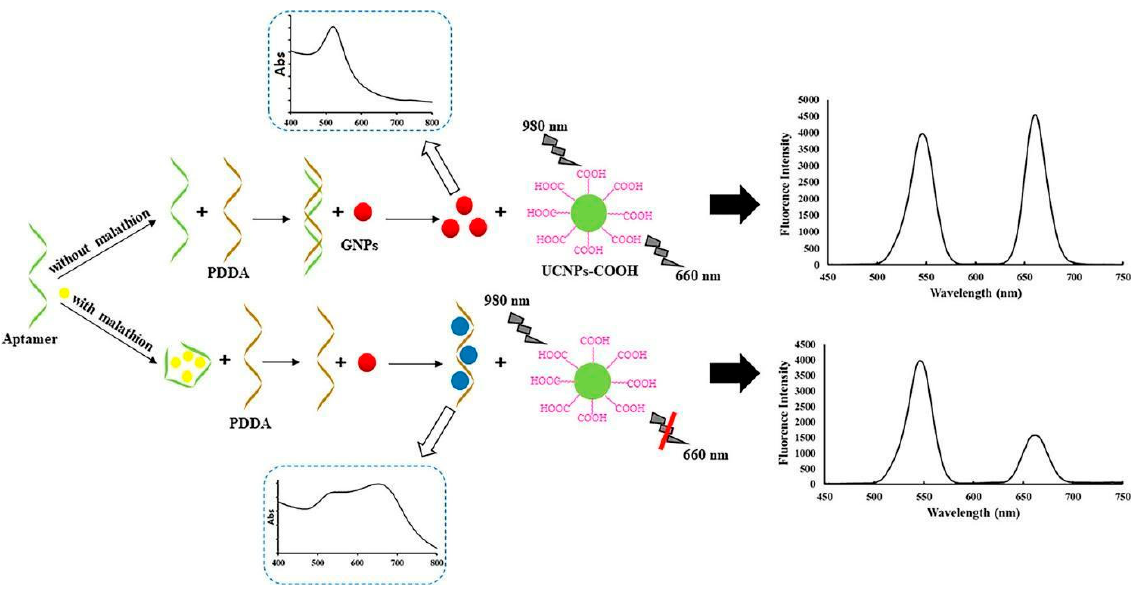
Figure 8. Schematic illustration of the aptasensor for malathion detection based on FRET between NaYF 4 :Yb,Er and gold nanoparticles ( GNPs). (Reprinted from reference [62] with permission from Elsevier).